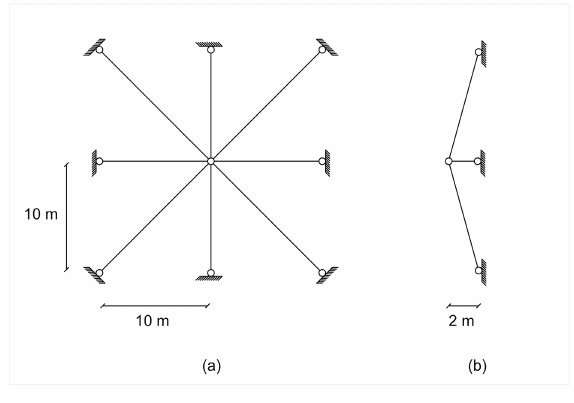
Figure 3: Geometry of the eight-member lattice structure: (a) top view; (b) lateral view